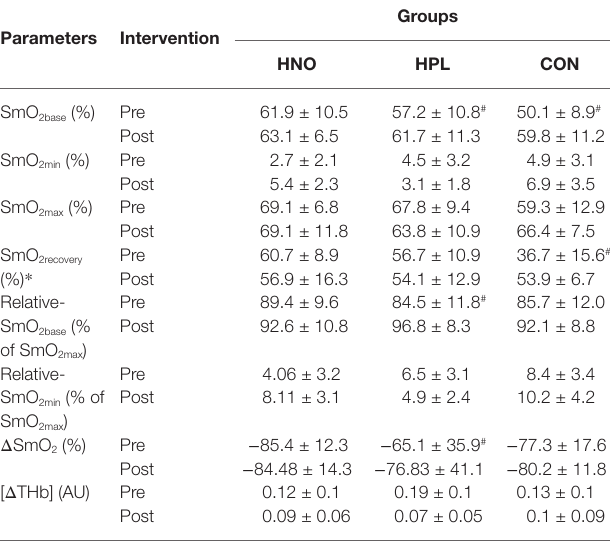
TABLE 3 | Mean ± SD values for the muscle oxygenation parameters obtained during the 3AOT for high-intensity exercise training sessions performed in hypoxia with NO 3 − (HNO), in hypoxia with placebo (HPL), and in normoxia with placebo (CON).